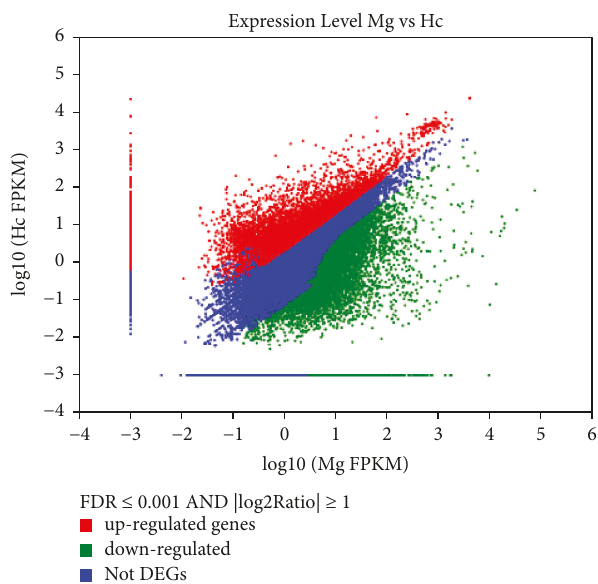
Figure 3: Comparison of unigene expression between the midgut and hemocytes of Helicoverpa assulta . The differentially expressed unigenes are shown in red and green, whereas those shown in blue were not differentially expressed between midgut and hemocytes. Red and green represent the rising and declining expression, re- spectively. With respect to expression profiles, midgut and he- mocyte genes are considered the control and treatment groups,